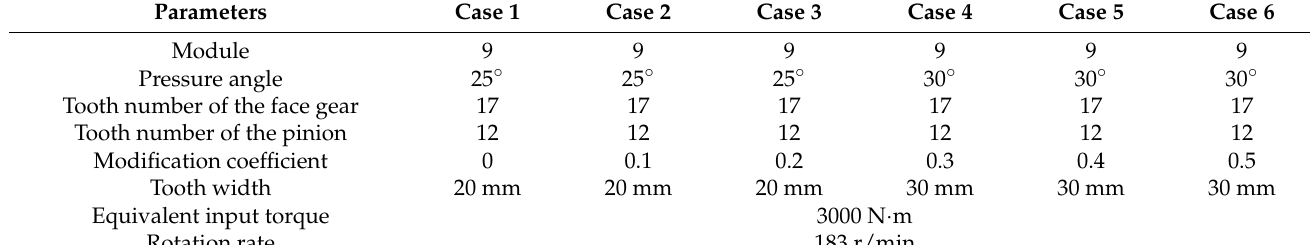
Table 1. Design parameters of profile shifted face gear.